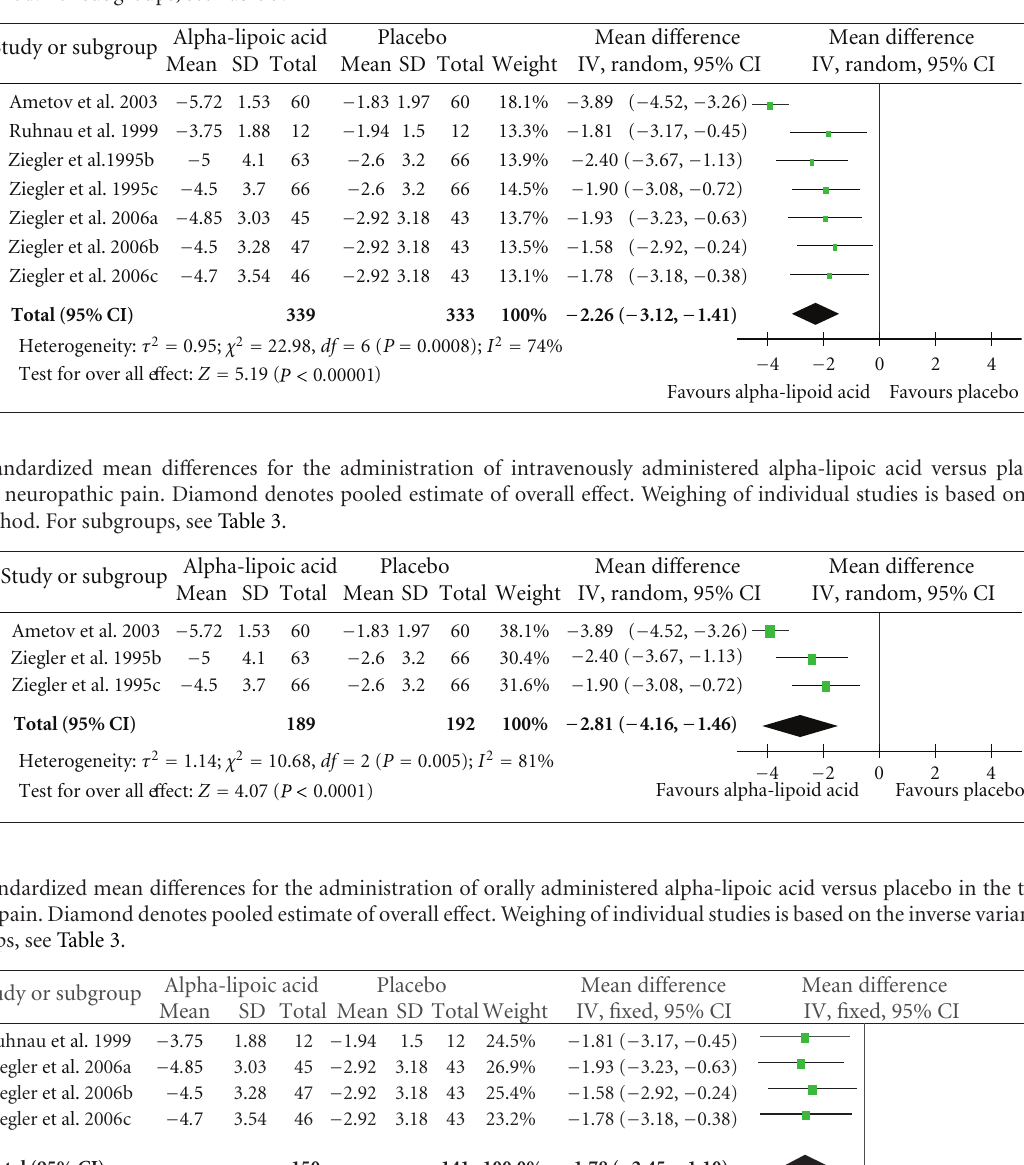
Table 4: Standardized mean di ff erences for the administration of orally and intravenously administered alpha-lipoic acid versus placebo in the treatment of neuropathic pain. Diamond denotes pooled estimate of overall e ff ect. Weighing of individual studies is based on the inverse variance method. For subgroups, see Table 3.